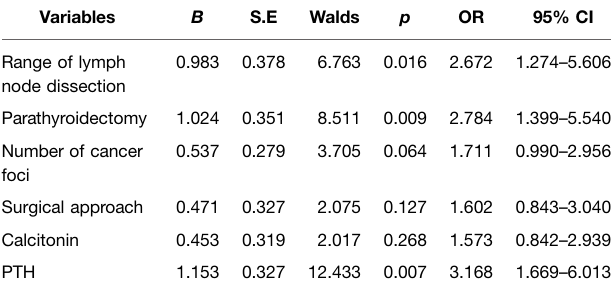
TABLE 3 | Multivariate analysis of postoperative EH in patients.